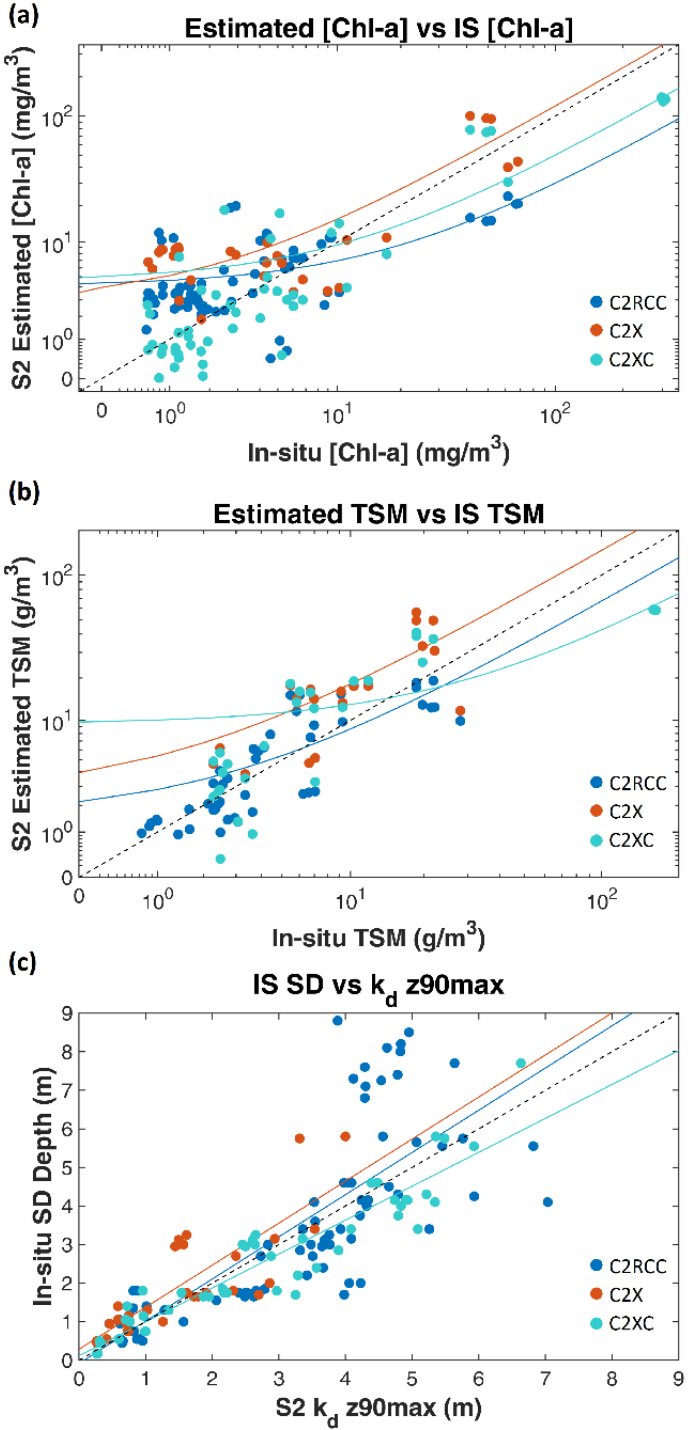
Figure 9. Scatter plots of in situ and C2-Nets estimated ( a ) [Chl- a ], ( b ) [TSM], and ( c ) Z SD . Plots in ( a ) and ( b ) are shown in logarithmic scale for ease of interpretation. The dashed line corresponds to a 1:1 line.